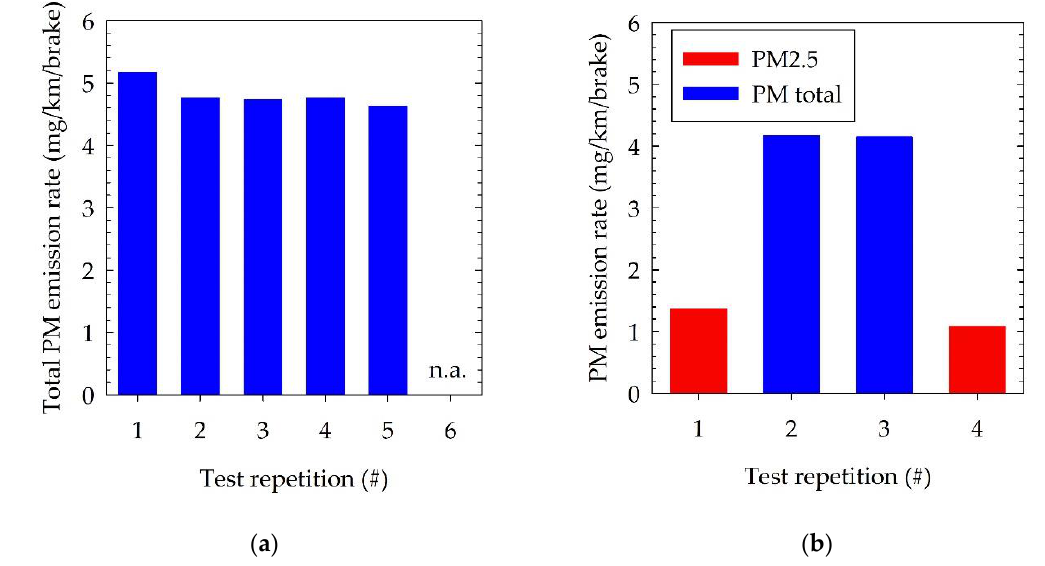
Figure 5. ( a ) Total PM emissions over 5 repetitions of the WLTP cycle for ECE#2 pads; ( b ) comparison of total PM and PM2.5 emissions over 4 repetitions of segment 10 of the WLTP cycle for ECE#2 pads.